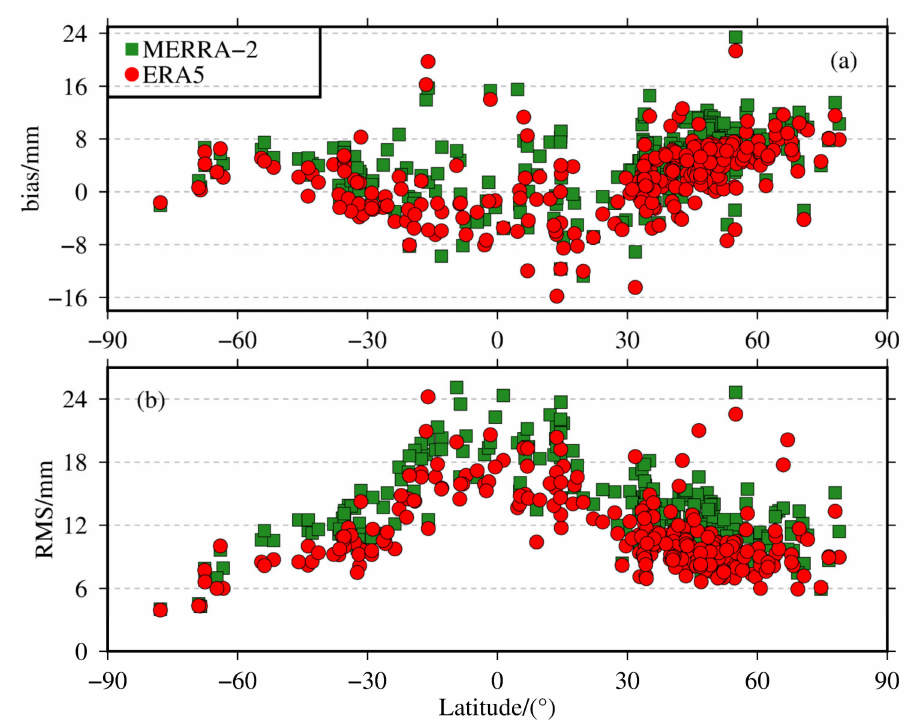
Figure 6. Variations with latitude of the annual average ( a ) bias and ( b ) RMS of ERA5 and MERRA-2 pressure-level ZTD with respect to GNSS ZTD over the globe from 2016 to 2017.